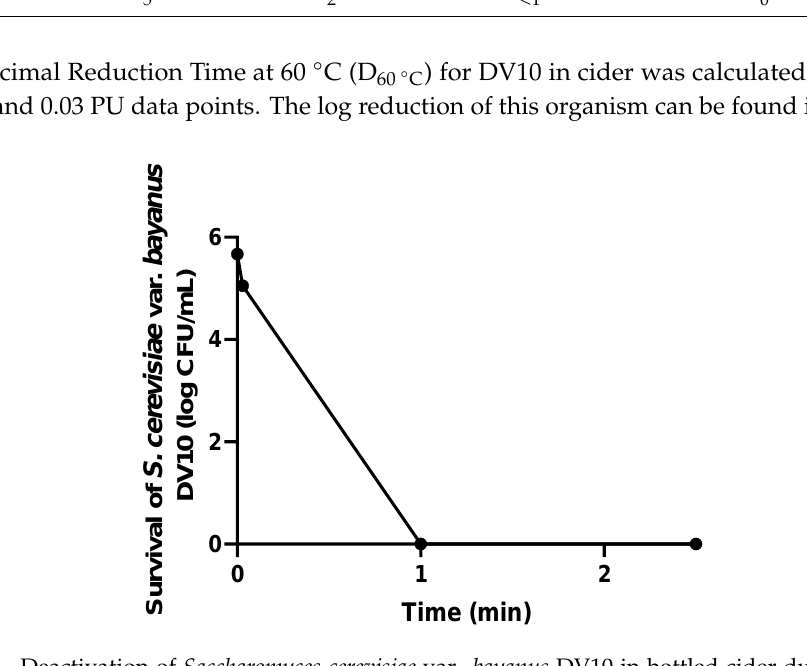
Figure 1. Deactivation of Saccharomyces cerevisiae var. bayanus DV10 in bottled cider during water bath pasteurization at 60 °C. Decimal Reduction Time at 60 °C (D 60 °C ) for this organism in cider was calculated to be 0.05 min.